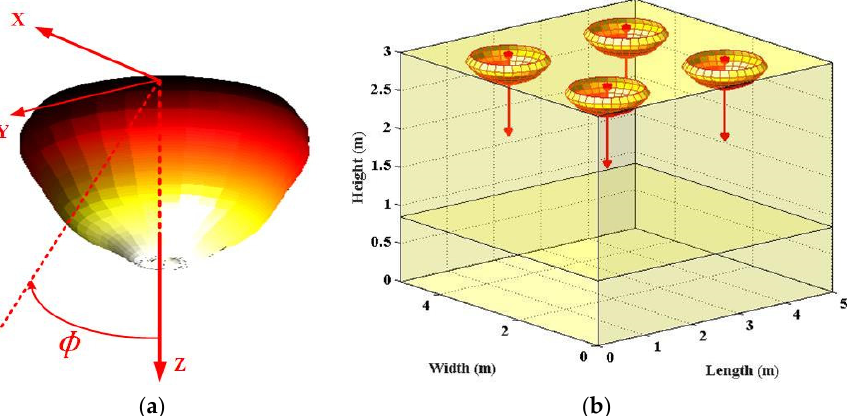
Figure 3. ( a ) 3D spatial optical beam of Side Emitter non-Lambertian LED; ( b ) Side Emitter non- Lambertian LED-applied indoor scenario, respectively.